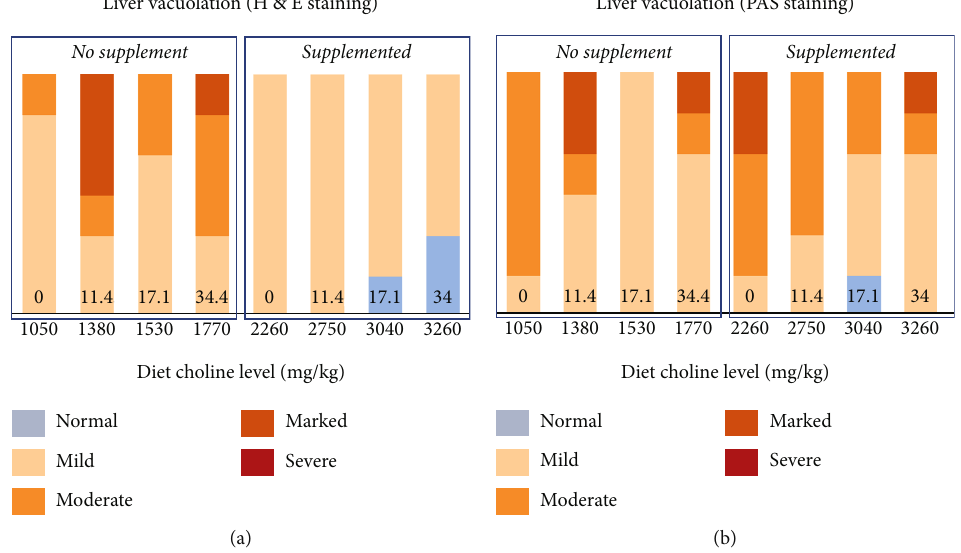
Figure 13: Results of histological examination of liver tissue for (a) vacuolation indicated by H&E staining and (b) vacuolation as indicated by PAS staining indicating carbohydrate accumulation in fi sh fed diets with increasing levels of FM, without (No supplement) or with (Supplemented) a mixture of 0.3% choline chloride, 0.05% β -glucan, and 0.05% nucleotides. Numbers at the bottom of the columns indicate the fi shmeal levels of the